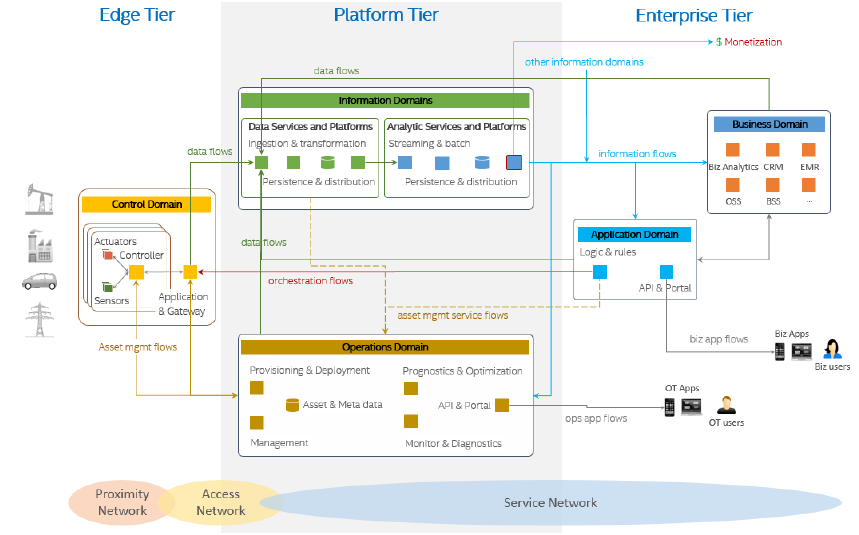
Figure 7. IIRA three-tier architectural pattern [2].